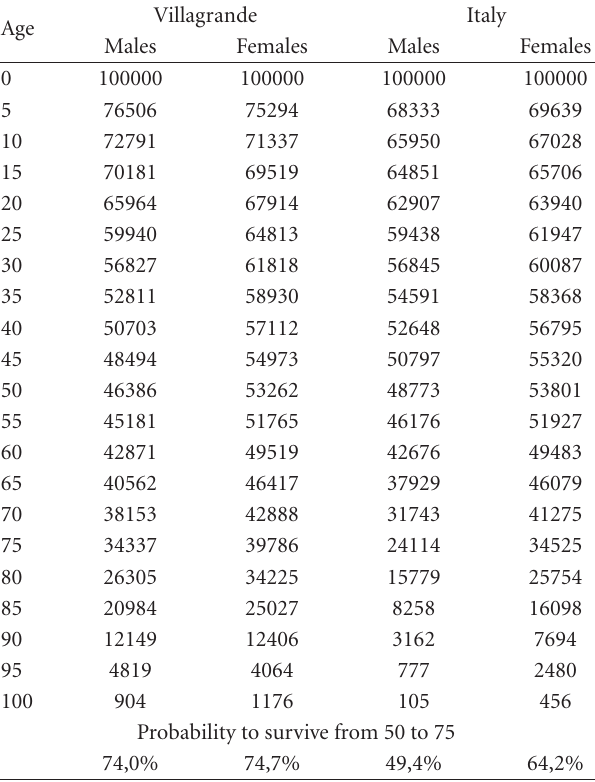
Table 2: Comparison of survival curves for males and females in Villagrande with the corresponding data extracted from the Human Mortality Database for the whole Italy (birth cohorts from 1876 till 1912 included).